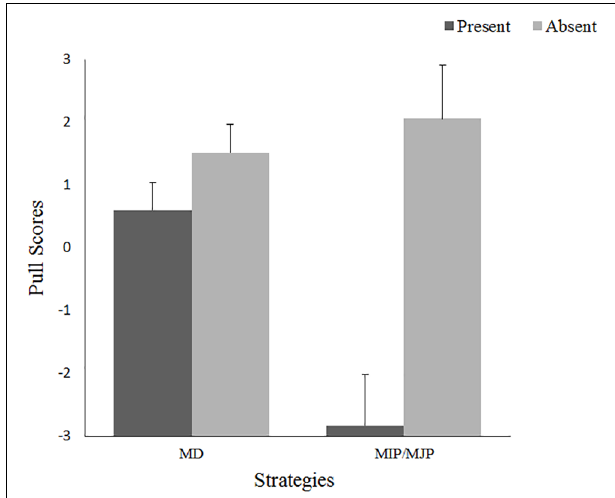
FIGURE 4 | Pull scores as a function of competitive intragroup outcome interdependence and strategies: Experiment